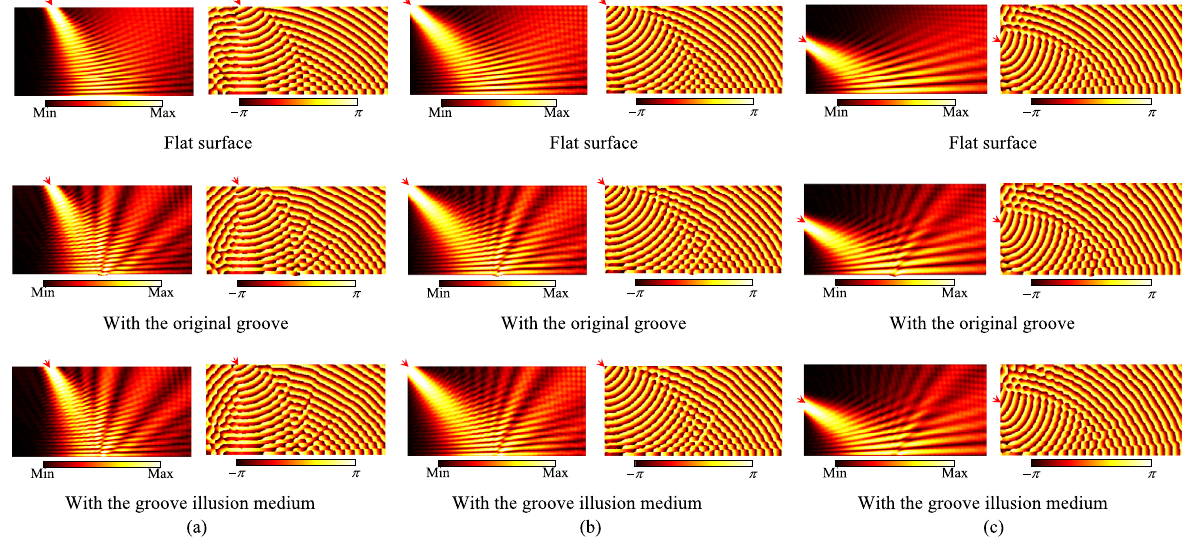
Fig. 12. Calculated complex voltage distributions for the cases with oblique incident waves at l g =12 D d (Top row: Flat surface. Center row: Original groove. Bottom row: Groove illusion medium). Left: Amplitude. Right: Phase. (a) u inc =30 deg. (b) u inc = 45 deg. (c) u inc =60 deg.